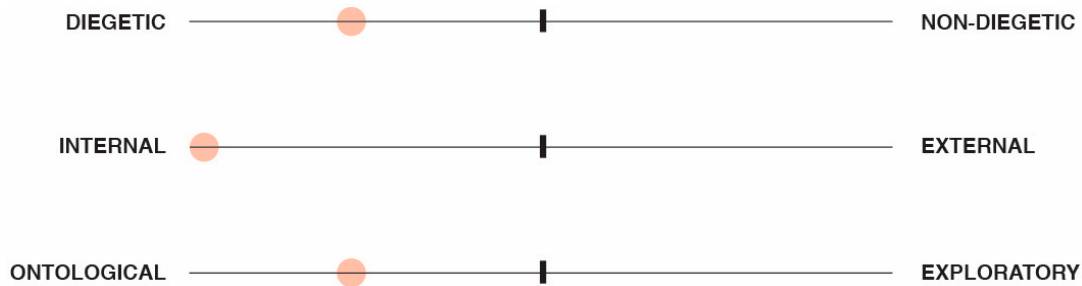
Figure 2. Mapping the Tangible Spatial Narratives project onto the TENF.